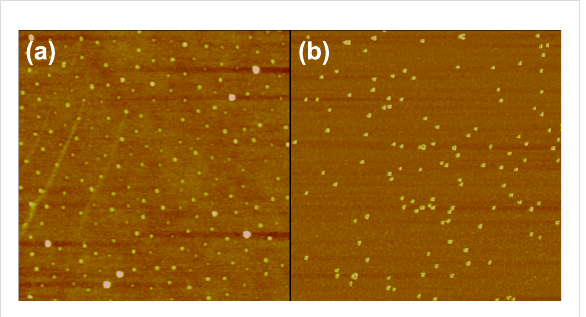
Figure 6: AFM images of 25 nm diameter gold nanoparticles deposited onto a silicon wafer. (a) Ordered organization as described in the Experimental section, (b) random distribution. Frame sizes: 3 µm and 1 µm,